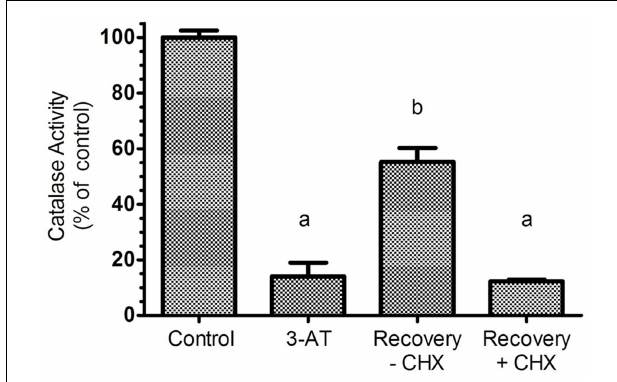
FIGURE 2 | Recovery of catalase activity requires protein synthesis. Hs27 cells were treated with 2mM aminotriazole for 24h followed by a 24h recovery period (in the absence of aminotriazole) with or without 100 μ g/mL of cycloheximide, an efficient inhibitor of protein synthesis. Results indicate that aminotriazole is an irreversible inhibitor of catalase, and for cells to recovery activity, synthesis of new catalase protein must occur. Determination of catalase activity is described in Section “Materials and Methods.” Letters represent values significantly different from the control and/or each other based on ANOVA analysis where p < 0.05.